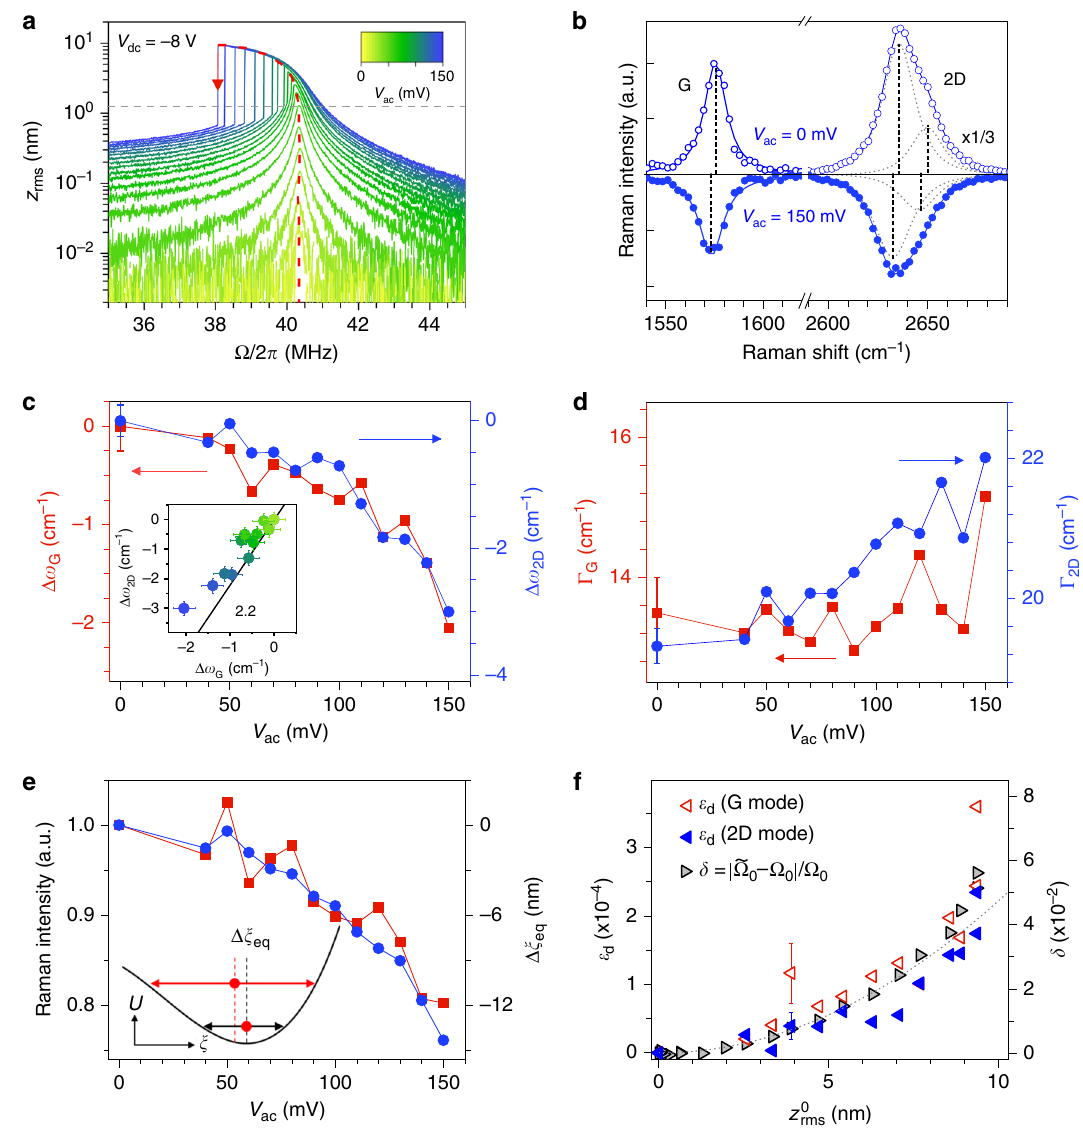
Fig. 2 Evidence for dynamically-enhanced strain in graphene. All measurements are performed on device 1 at V dc = − 8 V. a Calibrated RMS mechanical amplitude at the drive frequency Ω /2 π ( z rms ) recorded as the frequency is swept downwards, for V ac increasing from 0 to 150 mV. The red dashed line is the backbone curve evidencing non-linear resonance frequency softening. The red arrow indicates the jump-down frequency at V ac = 150 mV. The grey dashed line denotes the onset of non-linearity. b Raman spectra measured under V ac = 0 mV (open symbols and fi t) and 150 mV ( fi lled symbols and fi t, vertically fl ipped for clarity). c , d G-mode and 2D-mode frequency shifts Δ ω G,2D and full-width at half maximum variations ( ΔΓ G,2D ), relative to the values at V ac = 0 mV, as a function of V ac . Inset in c : correlation between Δ ω 2D and Δ ω G . The symbol colour encodes the increase of V ac as in a . The straight black line with a slope of 2.2 is a guide to the eye for strain-induced phonon softening. e Normalised integrated intensity of G-mode and 2D-mode features as a function of V ac . The inset illustrates the equilibrium position shift ( Δ ξ eq between the two red circles) in the non-linear regime, with U ( ξ ) the potential energy. f Time-averaged dynamical strain ε d extracted from the softening of G-mode and 2D-mode features (open red and fi lled blue triangles, respectively) as a function of the corresponding z 0 . The right axis (grey triangles) shows the relative non-linear mechanical resonance frequency shift (cid:2) (cid:2) rms (cid:2) (cid:2) = Ω e Ω δ ¼ e Ω (cid:2) Ω fi t (Supplementary Note 6). Error bars in c , d , f are 0 0 0 , where 0 is the jump-down frequency in a . The grey dashed line is a parabolic extracted from the fi ts of Raman spectra. Only one error bar is included in each plot for with z rms . The correlation plot between ω 2D and ω G reveals a linear slope near 2 (see also Supplementary Note 1), which is a characteristic signature of tensile strain 31,41 that gets as high as ≈ 9 nm. ≈ 2.5 × 10 − 4 for z rms Fig. 3a, we notice that while z rms fully saturates at drive frequencies above 33.5 MHz and ultimately starts to decrease near the jump-down frequency, the tensile strain keeps increasing linearly up to ≈ 2.5 × 10 − 4 as Ω /2 π is raised from 33.2 MHz up to 34.5 MHz.